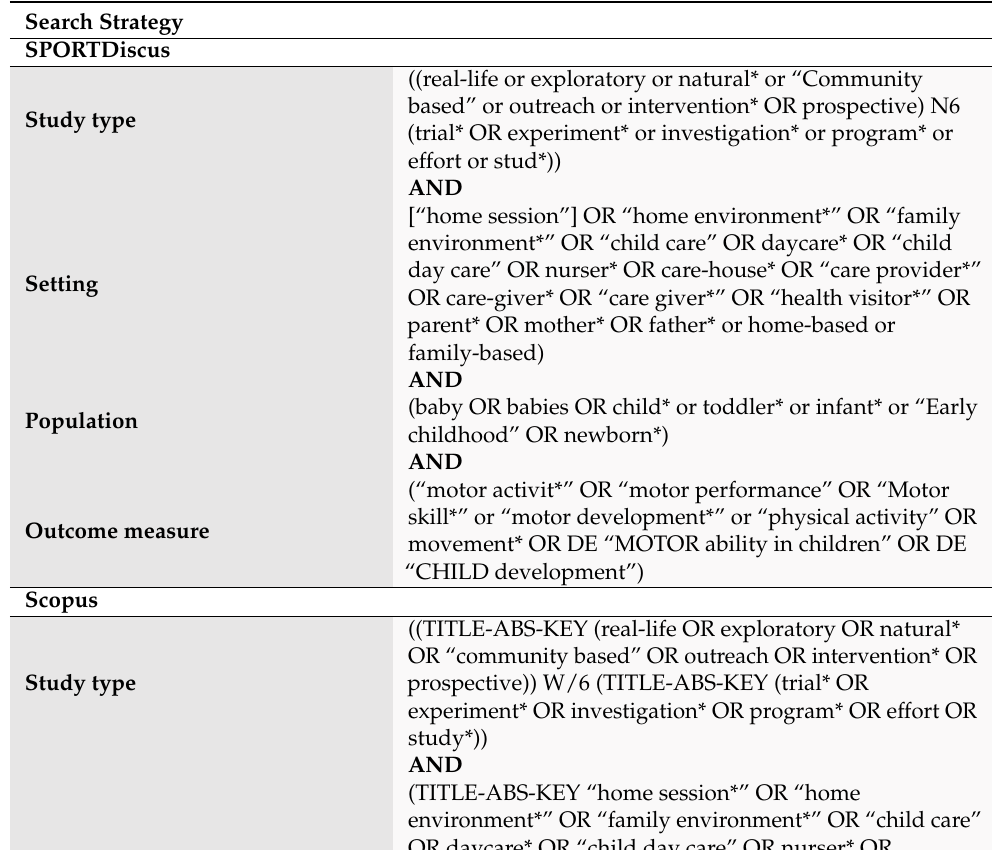
Table 2. Search strategy in the five